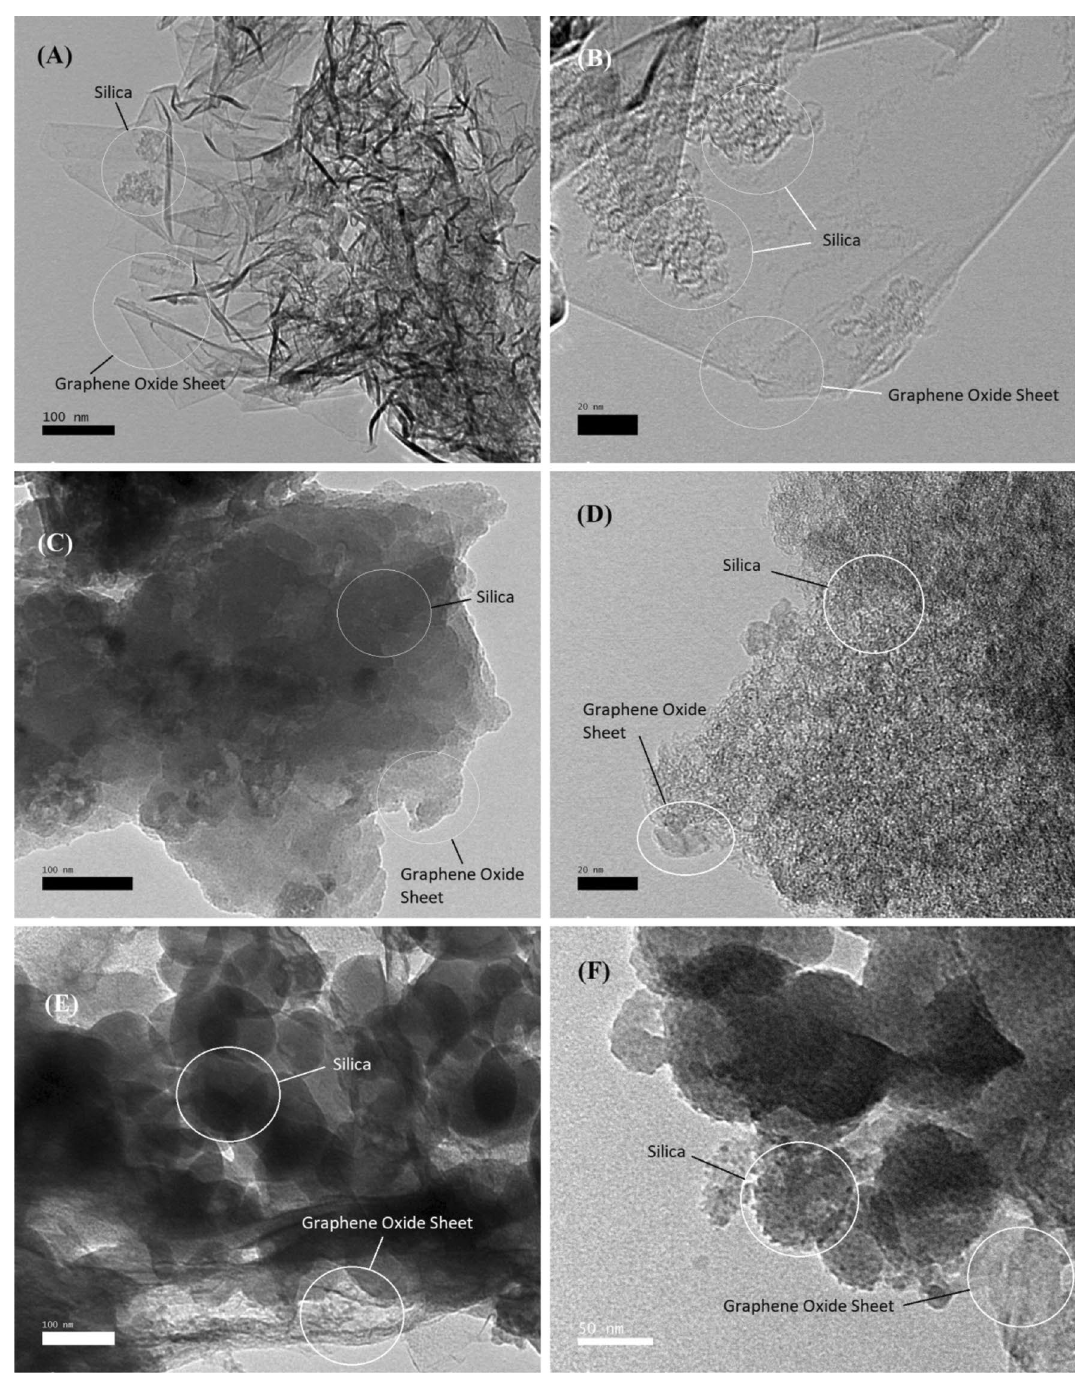
Figure 5. TEM images of prepared GO/SiO 2 nanocomposites: ( A , B ) FGS1, ( C , D ) FGS2, and ( E , F )